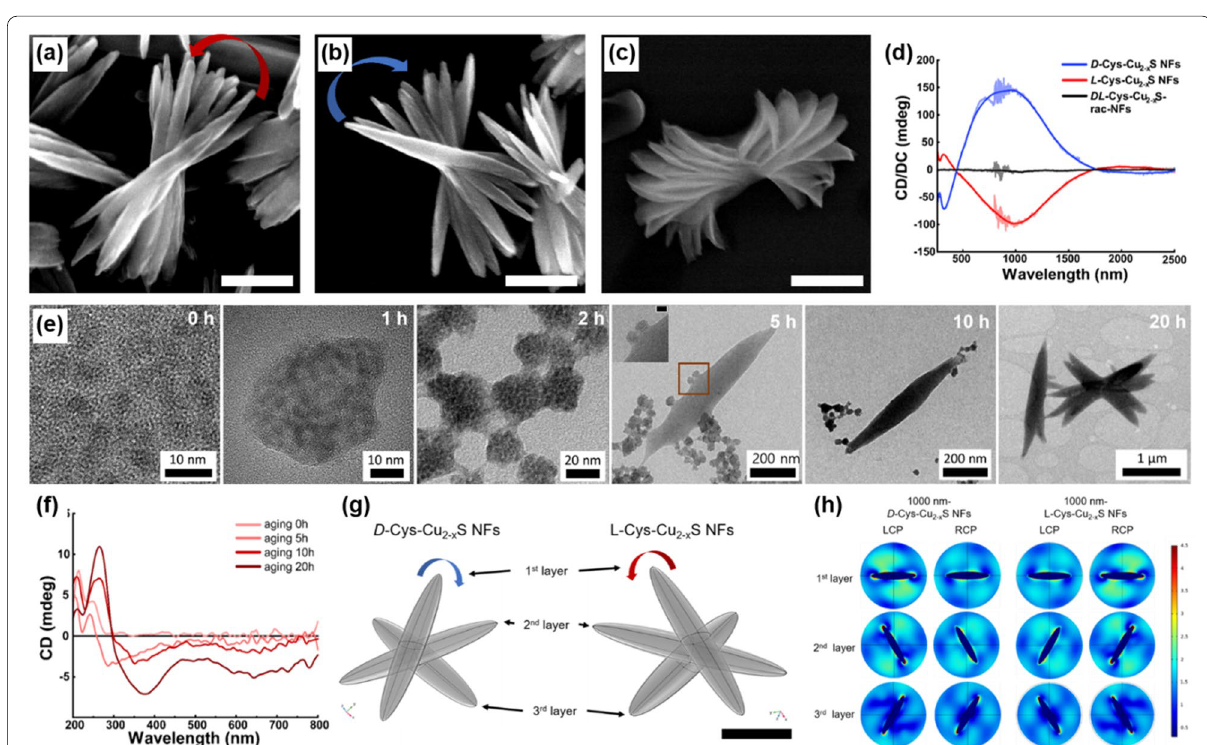
Fig. 18 a – c SEM images of a l -Cys, b d -Cys, and c dl -Cys-Cu 2-x S NFs. d CD spectra of thin films of NFs on quartz wafer ( l -Cys (red), d -Cys (blue), dl -Cys (black)). Scale bars = 500 nm. e TEM images of the different stages during the NF formation. f CD spectra of the intermediate stages by aging time. g Top view of l -, d -Cys-Cu 2-x S NFs models used in computational simulation (ellipsoid shaped nanoleaves stacked counterclockwise for l -Cys and clockwise d -Cys). Scale bars 500 nm. h Electric field distribution of each layer in d -Cys-Cu 2-x S NFs and l -Cys-Cu 2-x S NFs model with 1000 nm = LCP and RCP. Reproduced with permission from [105]. Copyright American Chemical Society,